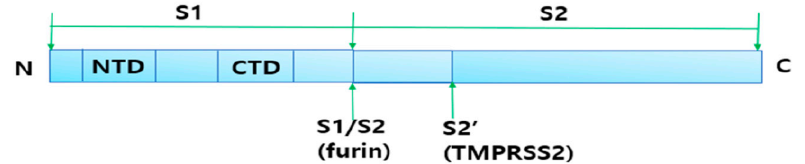
Figure 2. Spike (S) protein cleavage sites. The spike protein (S) trimer is a transmembrane protein, which gives the virus its crown-like appearance. The spike protein with 22 glycosylation sites has two ectodomains, S1 and S2, which are mandatory for recognition and binding to the host’s angiotensin- converting enzyme 2 (ACE2) receptors and are involved in viral fusion, respectively. The S1 domain contains 2 subdomains that include an N-terminal domain (NTD) and a C-terminal domain (CTD), which both could work as receptor-binding domains (RBD). The spike protein needs to be cleaved by the host enzymes furin and transmembrane protease serine subtype (TMPRSS2). The S1/S2 site is cleaved by furin and the S2’ site is cleaved by TMPRSS2. These proteases are essential for receptor recognition and viral entry into host